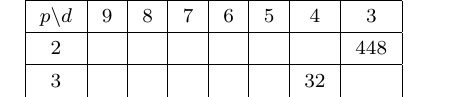
-branes in the p -brane multiplet in d -dimensions [17]. (7;6) p \ d